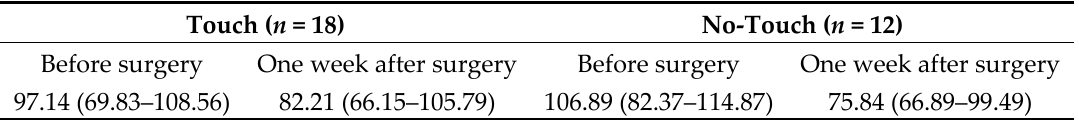
Table 1. Plasma FXIII-A levels (%) in OPCAB patients stratified according to type of surgical procedure (values are median and interquartile